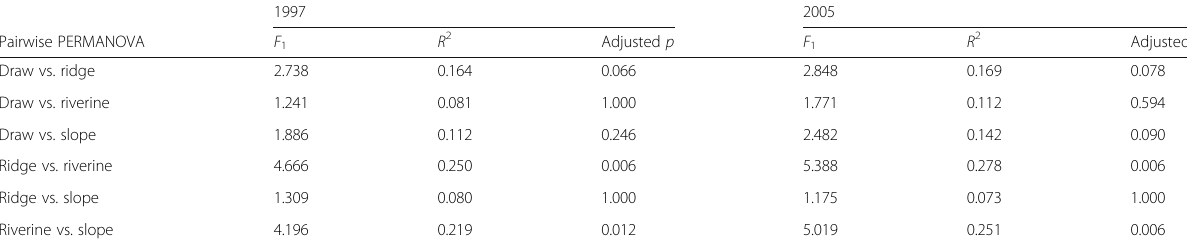
Table 2 Pairwise PERMANOVA (ADONIS) results for between-landform differences in species diversity 1997 Pairwise PERMANOVA F 1 R 2 Adjusted p F 1 R 2 Adjusted p Draw vs. ridge Draw vs. riverine Draw vs. slope Ridge vs. riverine Ridge vs. slope Riverine vs.